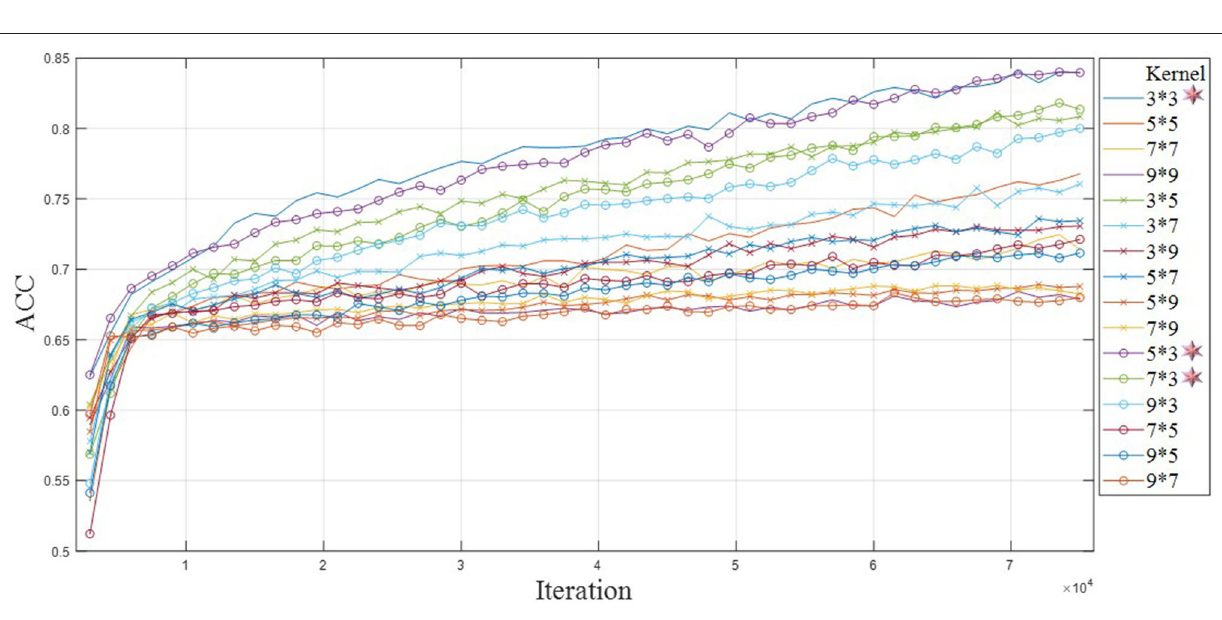
FIGURE 7 | Test accuracy of single-scale convolution